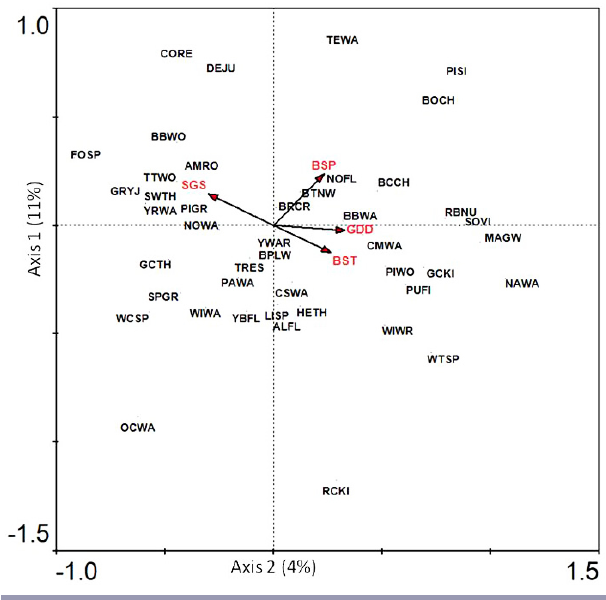
Fig. 3 . Ordination based on redundancy analysis (RDA) with spatial and habitat variables as covariates showing the first and second axes. Species are indicated by four-letter codes (see Appendix 1 for species codes). Arrows represent significant climate variables (GDD: number of growing days, BST: breeding season temperature, BSP: breeding season precipitation, SGS: start of growing season). The proximity between bird species and arrows indicates the importance of the influence of that environmental variable on the abundance and distribution of the bird species. Axis 1 runs horizontally, axis 2 runs